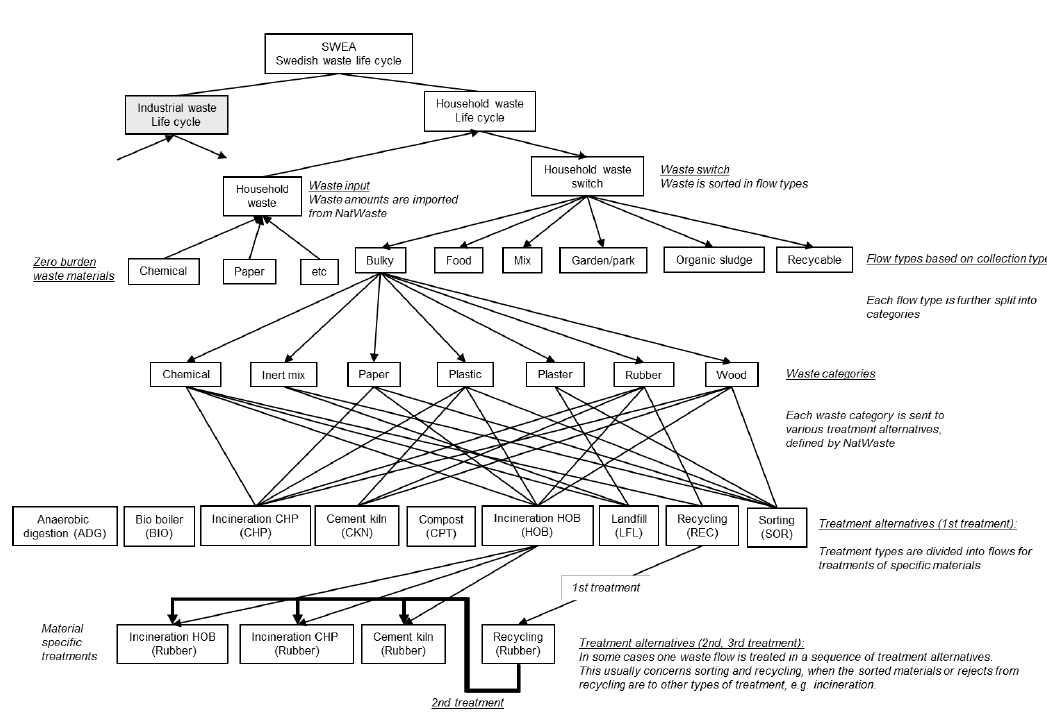
Excel Table S1: waste composition, Excel Table S2: waste amounts is different scenarios per waste flow and per waste fraction; PDF Document S3: results of environmental assessment.